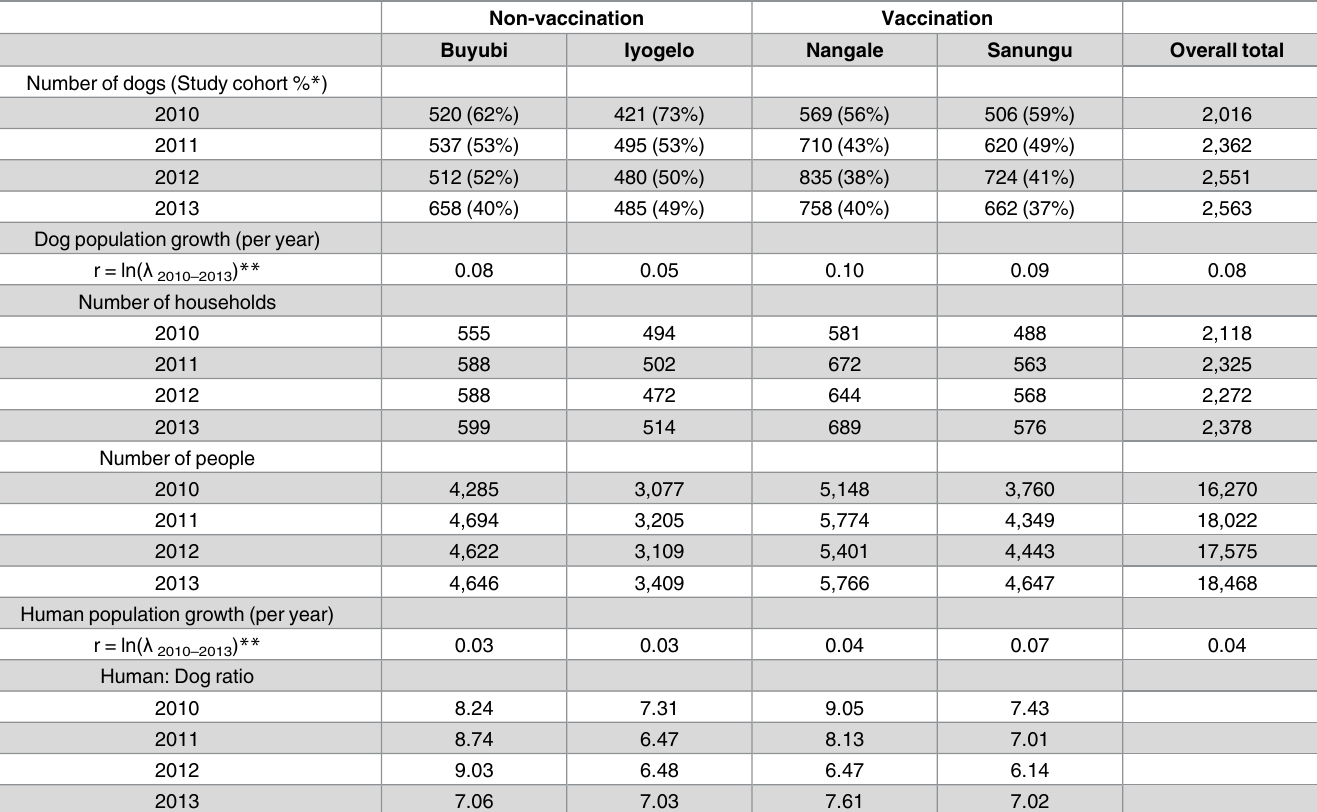
Table 3. Study cohort, village dog and human population census totals and estimated growth rates